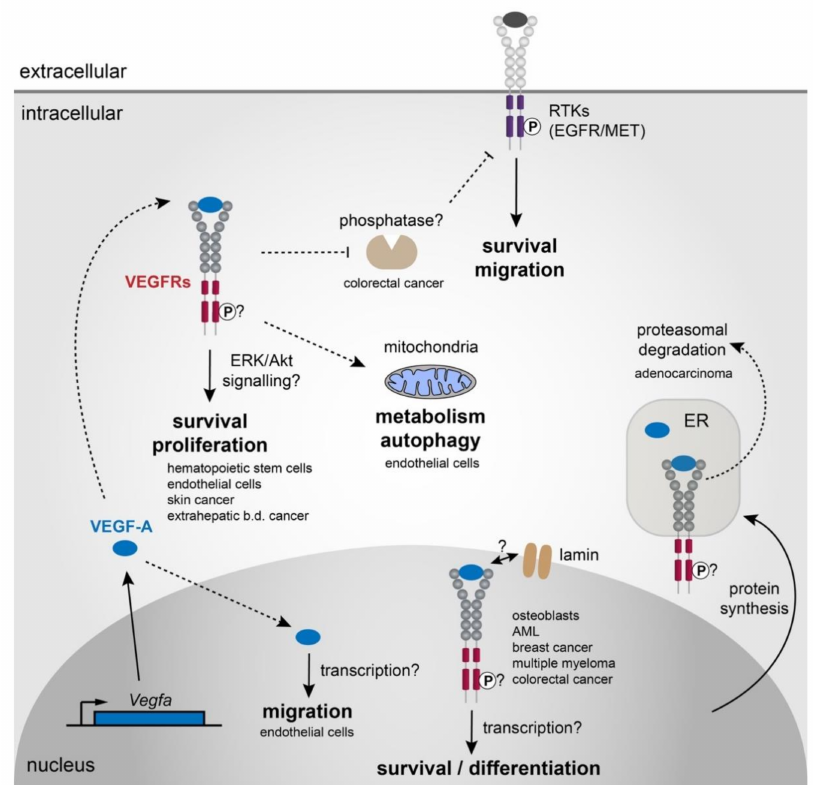
Figure 2. Potential mechanisms of intracrine VEGF-A signalling. VEGF-A may act via several